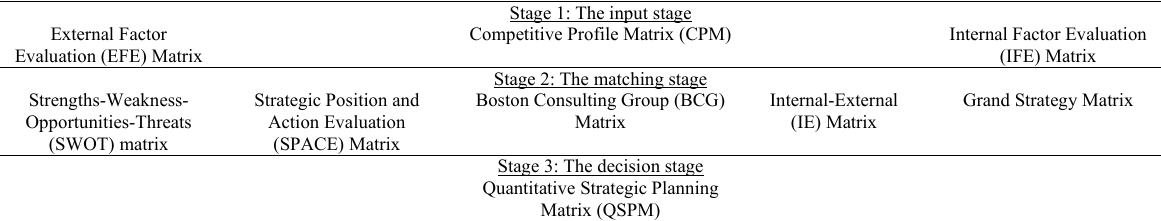
Fig. 1. The Strategy-Formulation Analytical